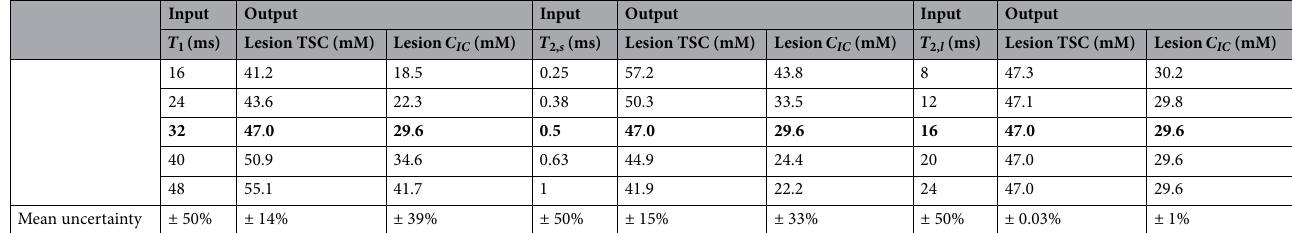
Table 2. Error propagation from uncertainty of 23 Na relaxation times. In the left section the mean TSC and C IC in an ROI containing the lesion (Patient 1 in Fig. 5) is reported for different values of 23 Na T 1 . In the central section mean TSC and C IC in the lesion are reported for different values of T 2, s . in the rightmost section mean C IC and TSC of the tumor are reported for a range of T 2, l . In the last row the mean uncertainty, defined as mean percentage variation relative to the central values, is reported. The relaxation times that we set in our method and the corresponding mean quantification results in the lesion are highlighted in bold. Due to the scarcity of literature references for 23 Na relaxation times in breast cancer, an abundant range of relaxation properties (± 50%) was simulated. Notations are: C IC intracellular sodium concentration, TSC total sodium